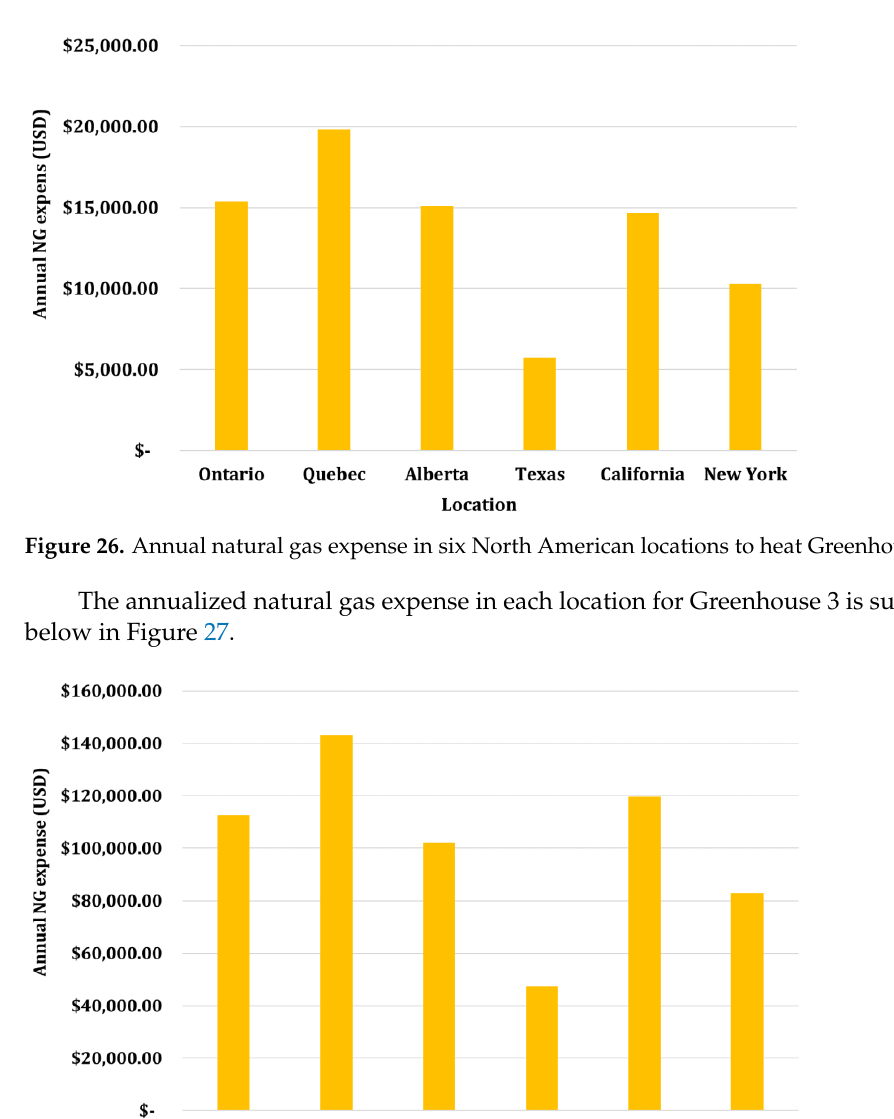
Figure 27. Annual natural gas expense in six North American locations to heat Greenhouse 3.